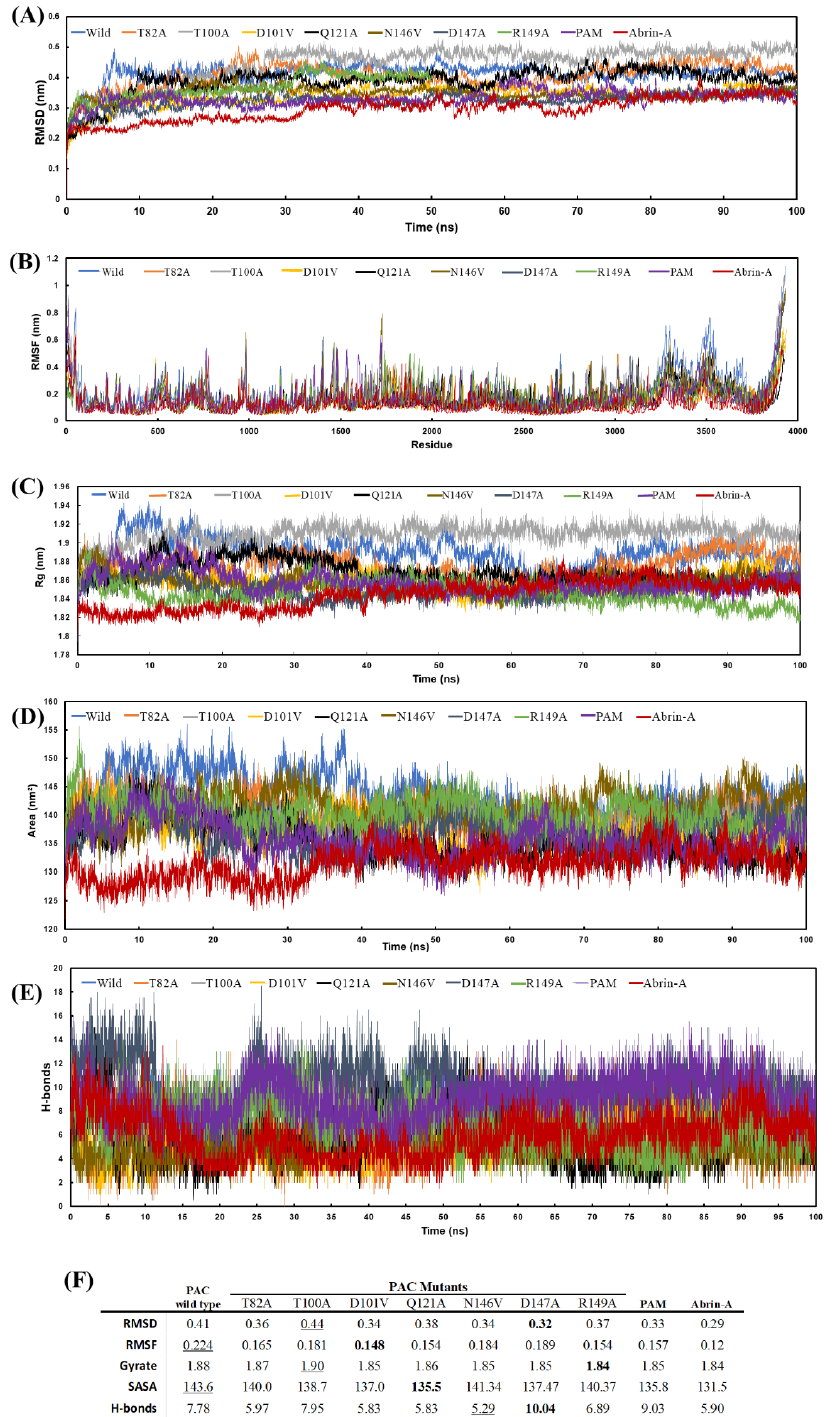
Figure 5. Information of main trajectories during MD simulations. ( A ) The RMSD of each complex was calculated after least square fit to protein backbone. ( B ) The RMSF shows backbone residual fluctuations of each mutant or toxin. ( C , D ) Radius of gyration and solvent accessible surface area indicating the reasonable compactness of complexes. ( E ) The mean number of H-bonds be-tween mutants or toxins and their ligand during a 100 ns MD simulation. ( F ) Average values of toxins- ligand complexes parameters obtained through simulation. Bold and underline boxes represented the highest and the least desirable values,